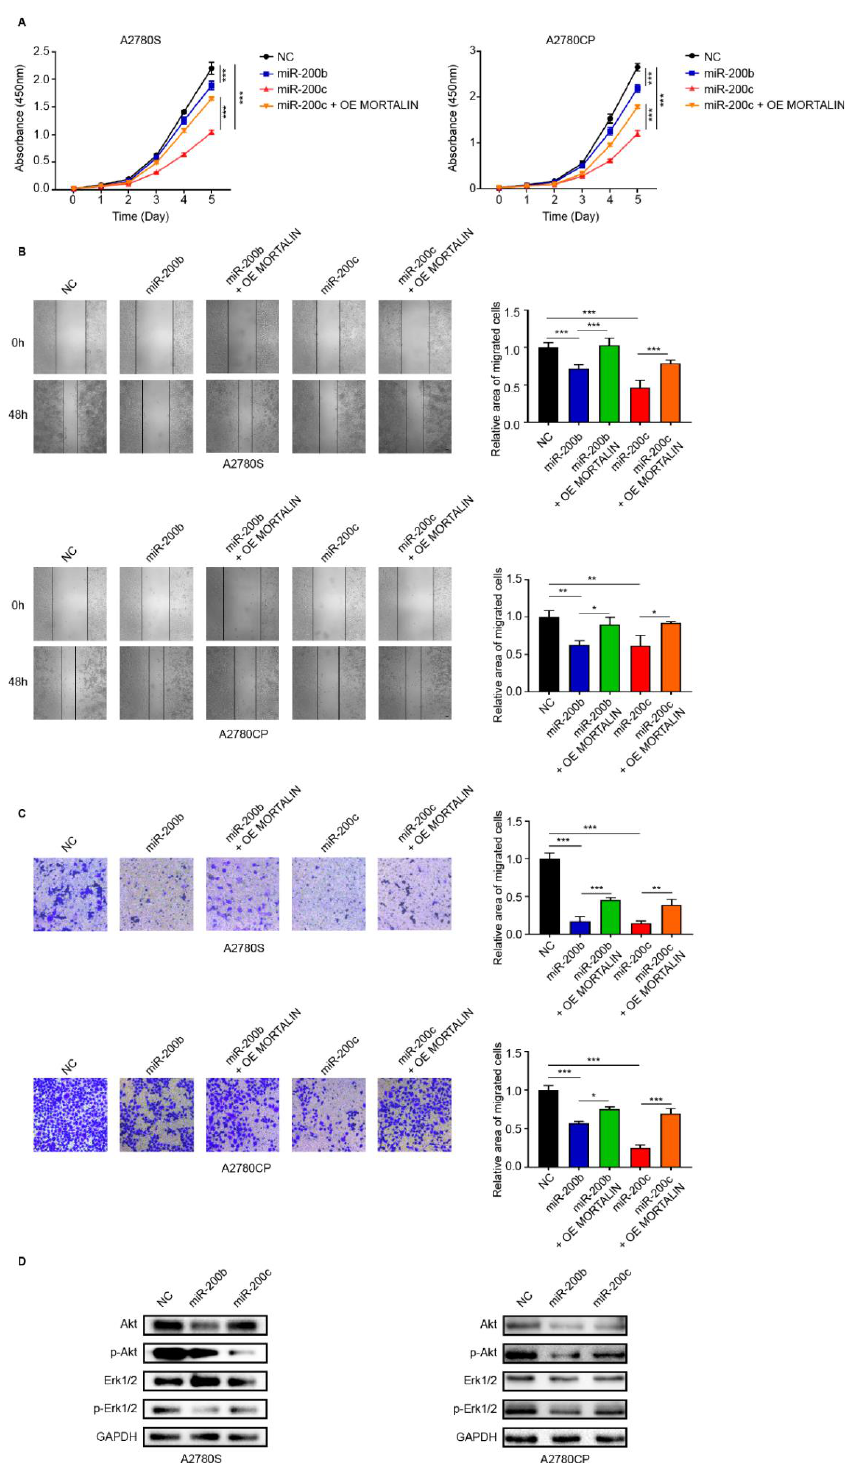
Figure 2. miR-200b/c decreases proliferation and migration of ovarian cancer cells via mortalin. After transfection of A2780S and A2780CP cells with miR-200b/c mimic or NC, ( A ) cell viability was determined using the CCK-8 assay. ( B ) Representative images from the wound healing assay of different groups at 0 and 48 h (scale bar, 50 µ m). Quantification of the wound-healing area. ( C ) Migration of ovarian cancer cells was determined via transwell assay (scale bar, 20 µ m). Average cell counts of 10 randomly selected fields. ( D ) Protein levels of Erk1/2, p-Erk1/2, Akt, and p-Akt were determined via Western blotting. Biological replication (n = 3). * p < 0.05, ** p < 0.01, *** p <